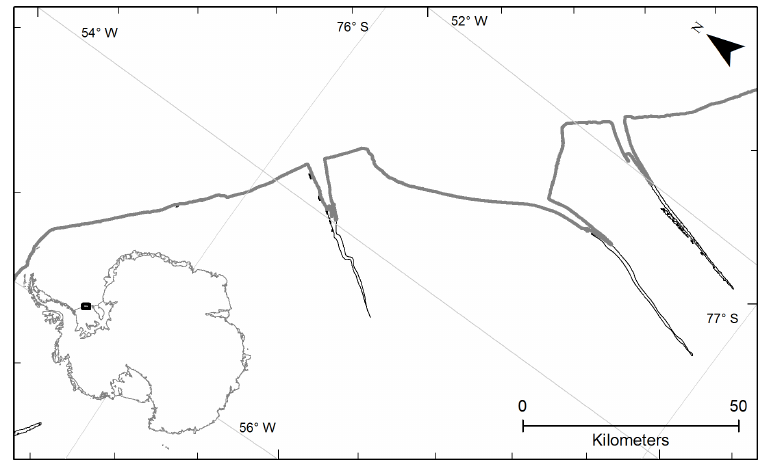
Figure 4. Map of orthogonal structures on Ronne Ice Shelf front. In the lower left corner of the figure the location of the Ronne Ice Shelf is shown. The grey lines represent the coastline taken from RAMP AMM-1 (http://bprc.osu.edu/rsl/radarsat/data/) and the grounding line taken from Haran et al .